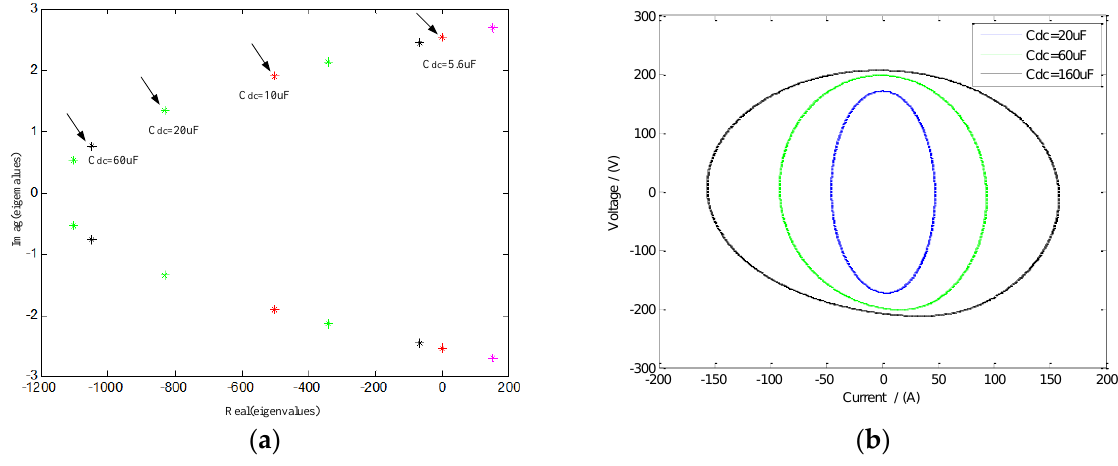
Figure 8. Influence of different filter capacitor parameters on system stability: ( a ) small signal stability;